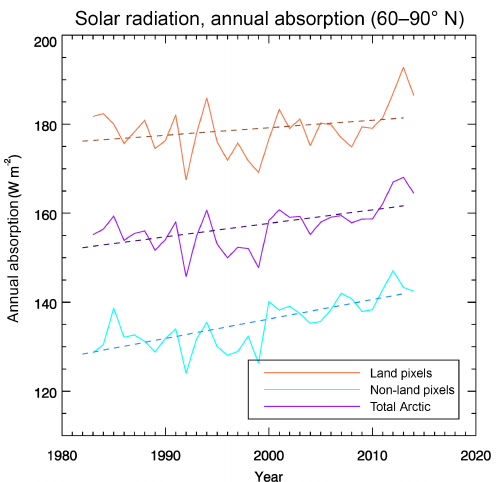
Figure 1. Average annual surface shortwave absorption (Wm − 2 ) from 60 to 90 ◦ N for the combined land and ocean area (purple), land only (orange), and ocean only (cyan). Dotted lines are linear